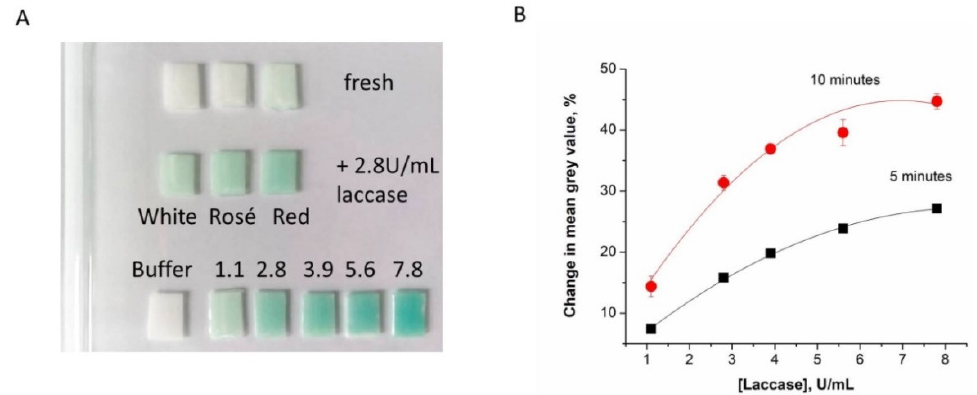
Figure 5. ( A ) Color development of ABTS-based paper sensors after 10 min of reaction with laccase solutions of increasing concentrations in the range 1.1–7.8 U/mL (lower lane) and of red, rosé, and white grape musts before and after the addition of 2.8 U/mL laccase (upper and middle lane). ( B ) Evaluation via ImageJ of the changes in the color of the paper sensors after 5 and 10 min of reaction with 1.1–7.8 U/mL laccase solutions, shown in ( A ).